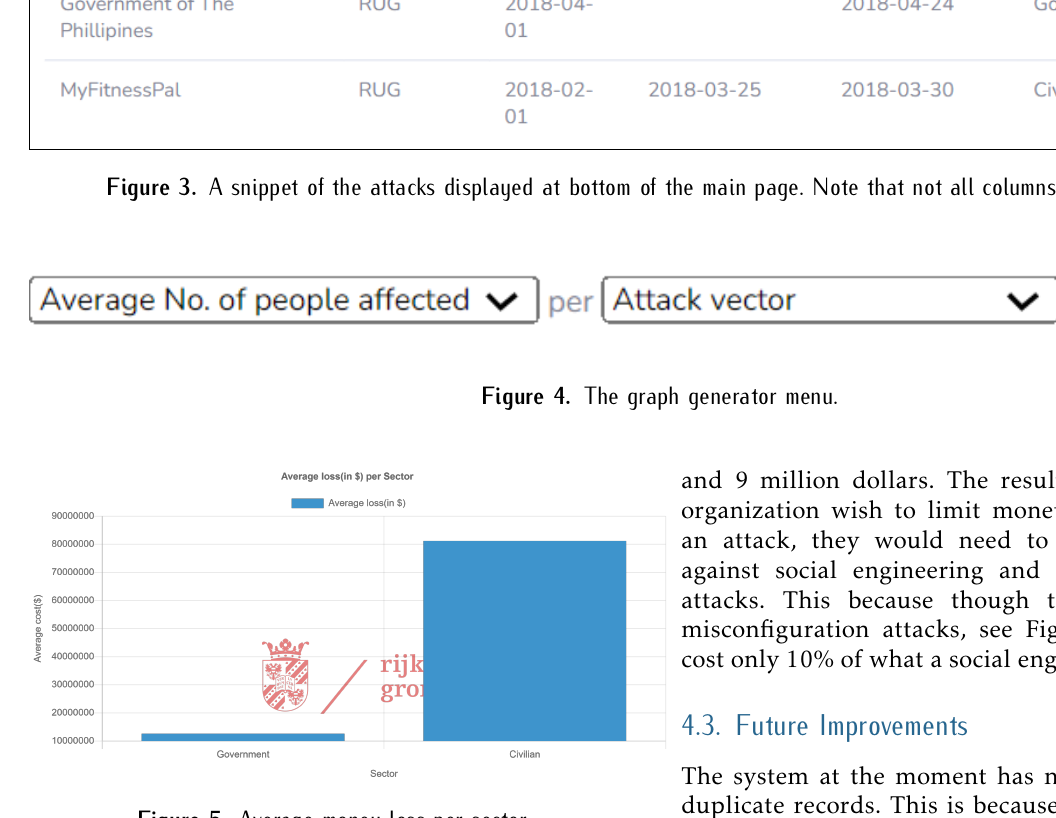
Figure 5. Average money loss per